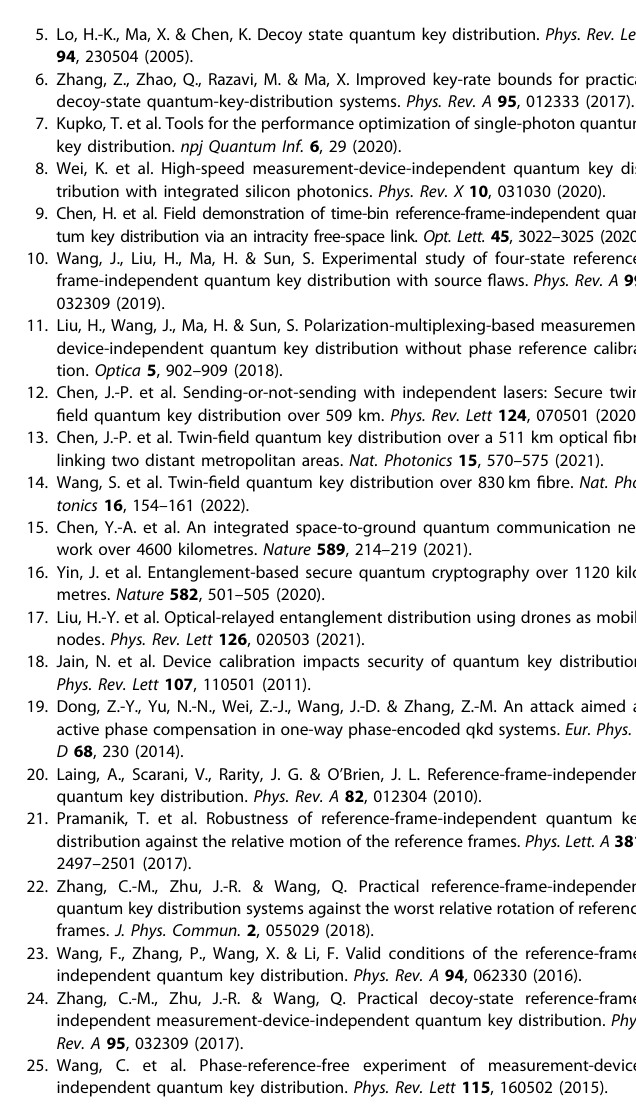
Fig. 7 Illustration of the 100 km free-running RFI QKD experiment. Two NI 6556 boards control the lasers and modulators. The computers are used for data acquisition, post-processing, and classical communication. An APD is used to measure the intensity of the signal and decoy states and the bits of Z basis, so that NI 6556 adjusts the control signal of IM1 and IM2. IM intensity modulator, BS beam splitter, PM phase modulator, PC polarization controller, AMZI asymmetric Mach – Zehnder interferometer, SNSPD superconducting nanowire single photon detector, TDC Time-to-Digital converter, APD avalanche photon detector, NI 6556 National Instruments